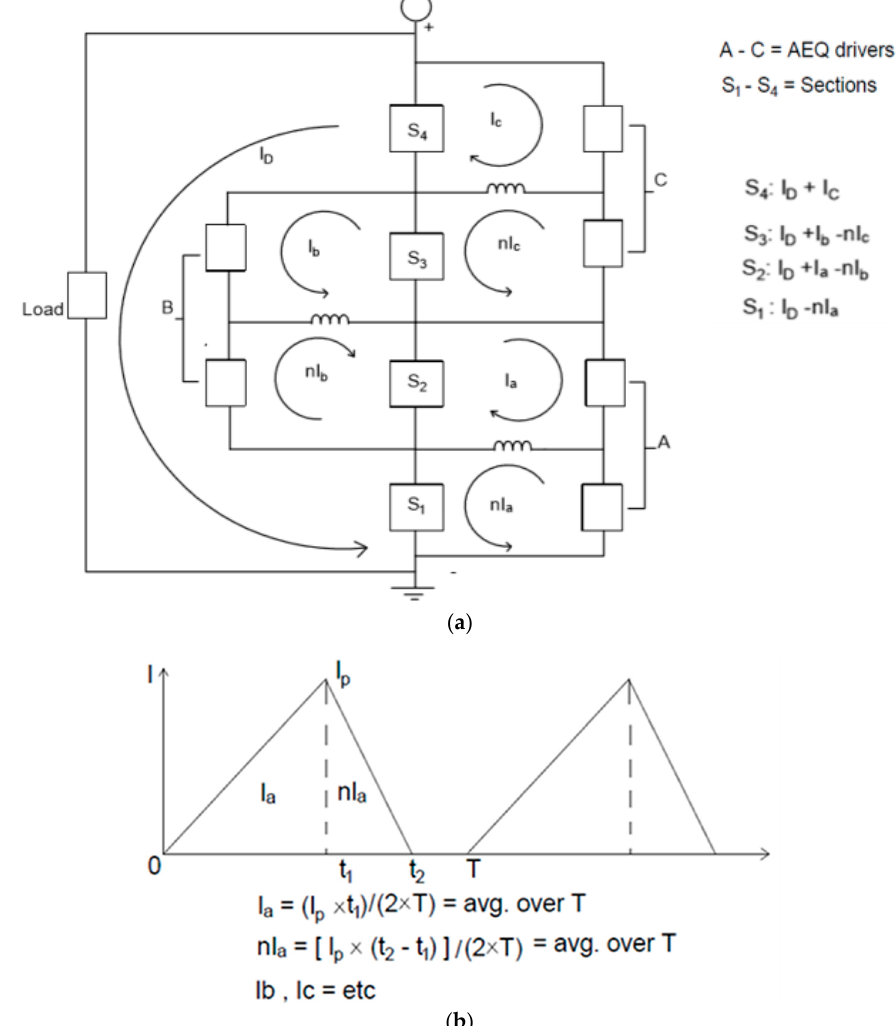
Figure 4. AEQ circuit for Examples 1 and 2. ( a ) Block diagram; and ( b ) inductor current example.